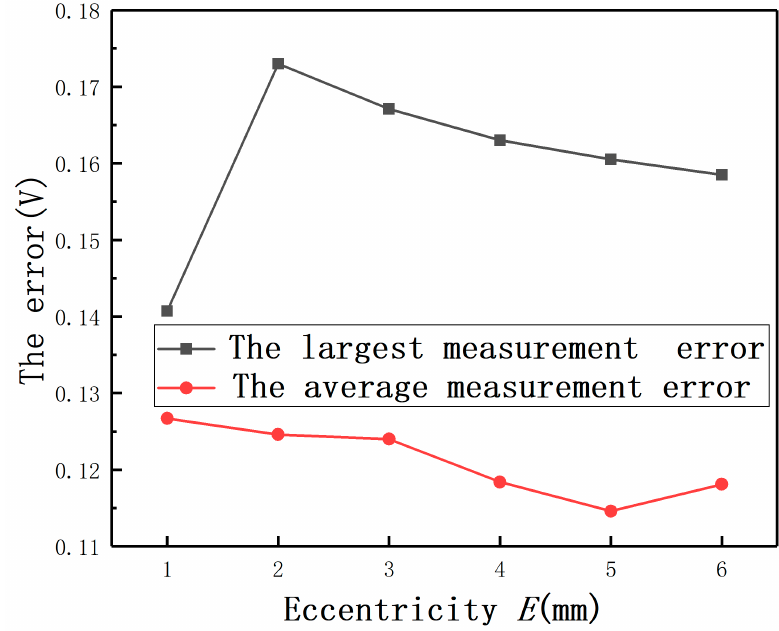
Figure 20. The largest measurement errors and the average measurement errors after compensation.